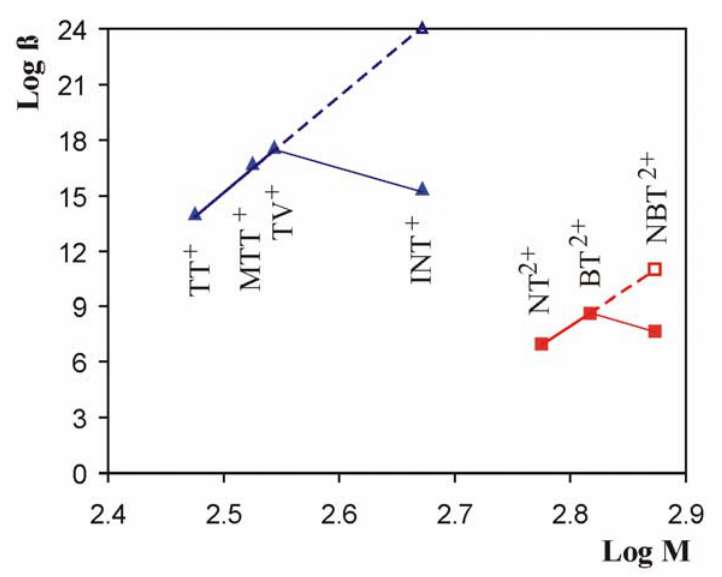
Fig. 6 Logarithm of association constant vs. logarithm of molecular weight of tetrazolium cation plots for the ion associates of [VO (TAR) ] 3 − with mono- and ditetrazolium salts. 2 2 TT + - triphenyltetrazolium cation [19], NT 2+ - neotetrazolium cation [21]; (cid:2) , (cid:3) - exper- imental data; (cid:4) , (cid:2) - calculated from the equation of the